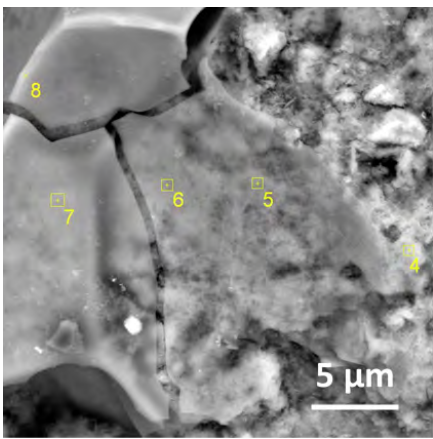
Figure 5. EPMA – EDX of perlite lamella and cement.